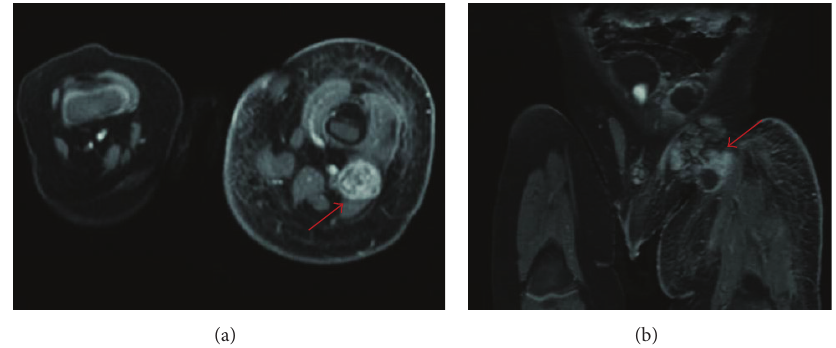
Figure 1: Axial (a) and coronal (b) T1-contrast-enahnced MR images through the thighs are shown. There is a heterogeneously enhancing mass in the posterior thigh involving the adductor compartment (arrow in (a)). There are also several enlarged external iliac lymph nodes: some with cystic and necrotic changes (arrow in (b)). Note the enlargement of the left lower extremity and significant soft-tissue edema and fat stranding.